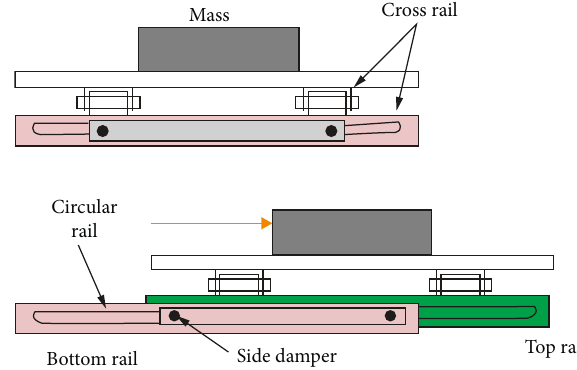
Figure 2: Roller-type isolation